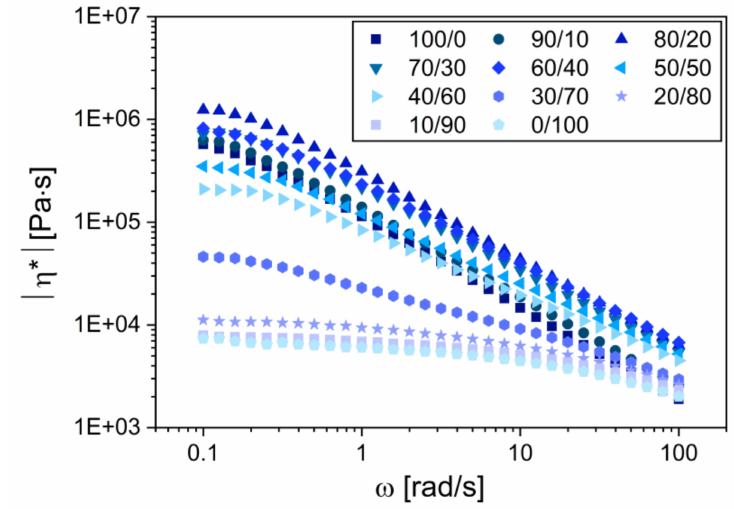
Figure 3. Absolute value of the complex viscosity (| η *|) as a function of oscillatory shear angular frequency ( ω ) during the oscillatory shear measurements for all TPS/PCL